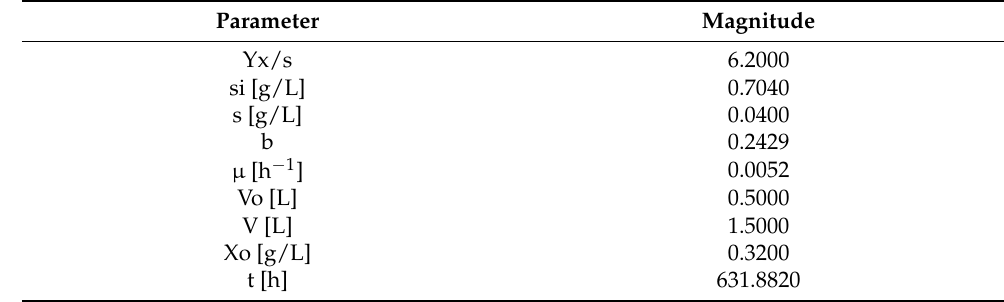
Table 1. Parameters used to calculate the experimental time in fed-batch culture.